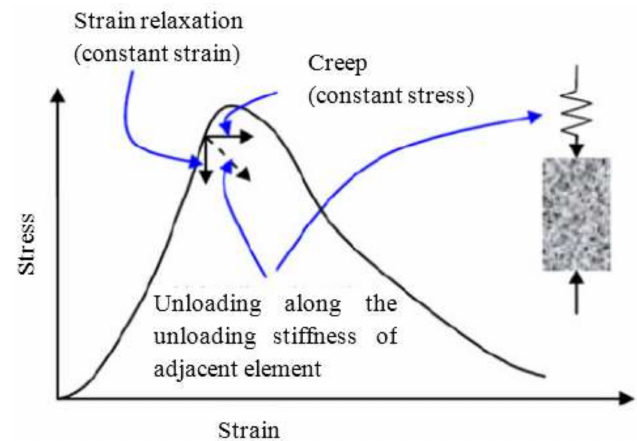
Figure 1. Possible stress-strain paths during testing for the time-dependent characteristics of rocks (from Hagros et al. 2008 [2]).